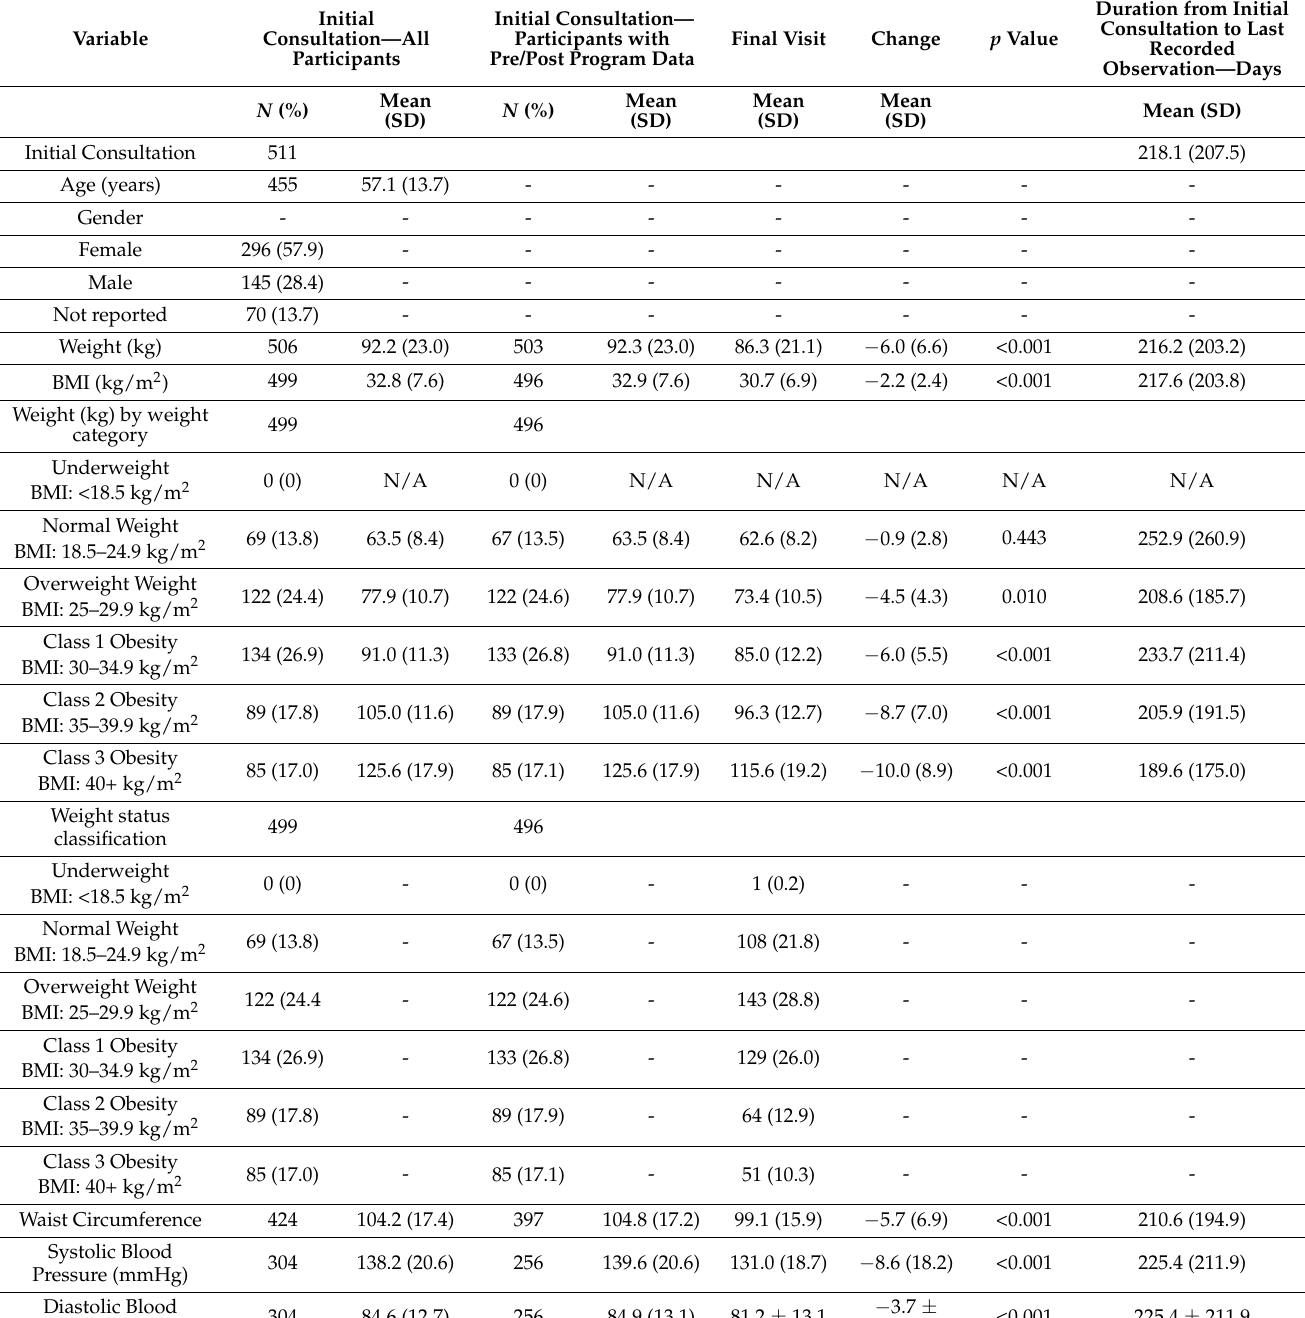
Table 2. Body weight, waist circumference and blood pressure data at commencement (initial consultation) and post program (final visit) of the Diversa Health program for all